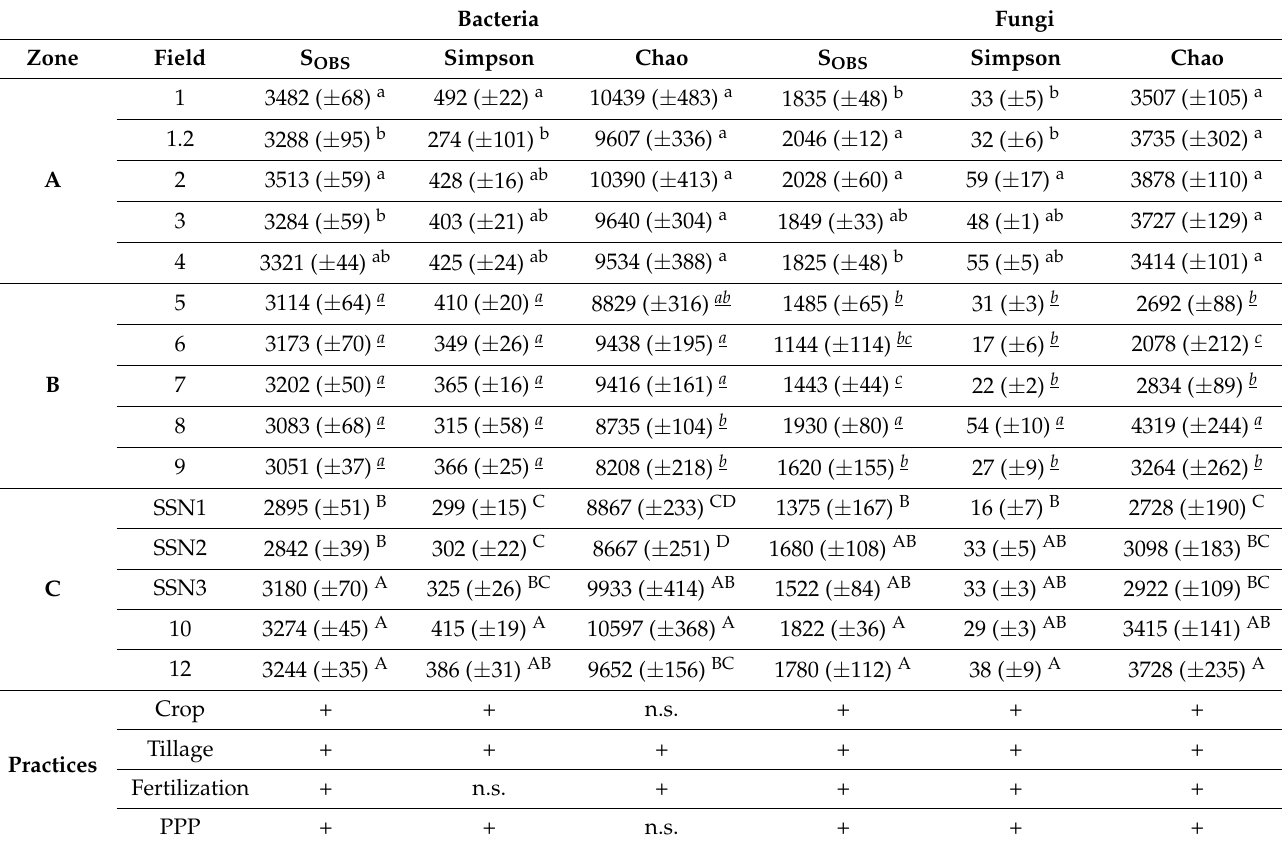
Table 2. Estimation of α -diversity indices and richness of each field separately for bacteria and fungi. The overall individual contribution of each practice on α -diversity is provided in the lower part (significance letters are formatted as a, a , A according to each zone and each diversity indicator. Different letters formatted in a similar manner indicate significant differences according to the one-way ANOVA carried out by LSD (Least Significant Differences) test at a 0.05 confidence. In the lower part of the table n.s.= not significantly contributing and + = significant contribution at p <